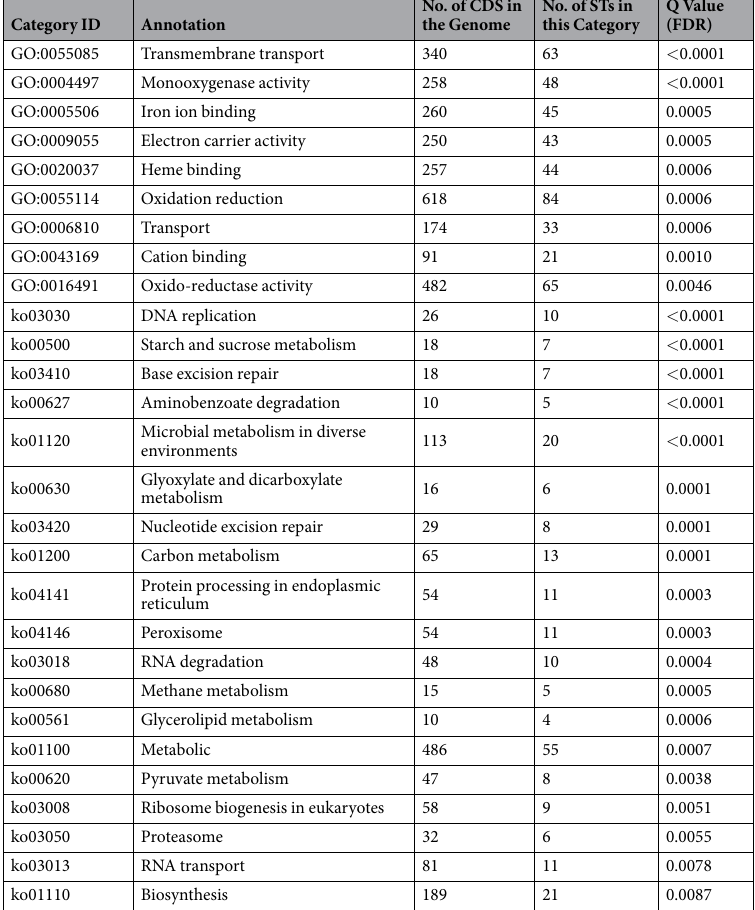
Table 1. List of significantly enriched GO terms and KEGG pathways for SAT pairs expressed in at least one of the three developmental stages.